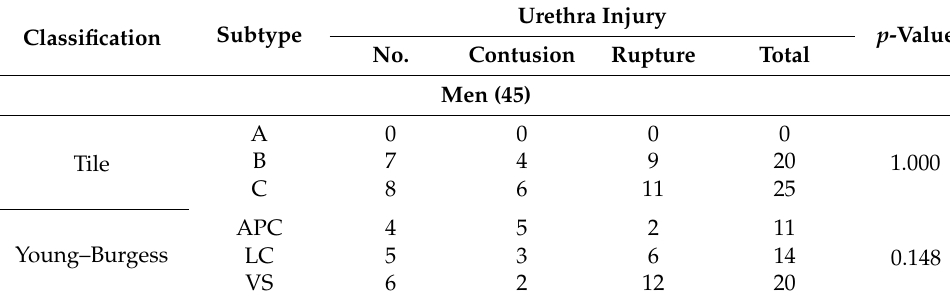
Table 6. Fracture pattern and injury to the male urethra ( n =